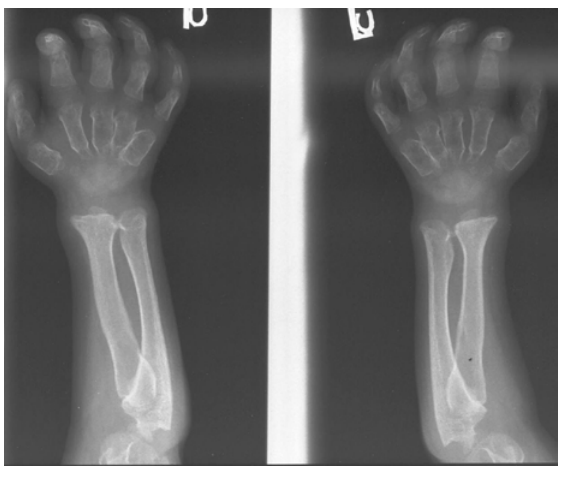
Figure 1. Rapidly progressing 7-year old female MPS VI patient: radiograph of hand. Typical radiological findings of MPS VI include thickened, short metacarpal bones with proximal pointing and thin cortices, carpal bones that are irregular and hypoplastic, V-shaped deformity of ulna and radius.